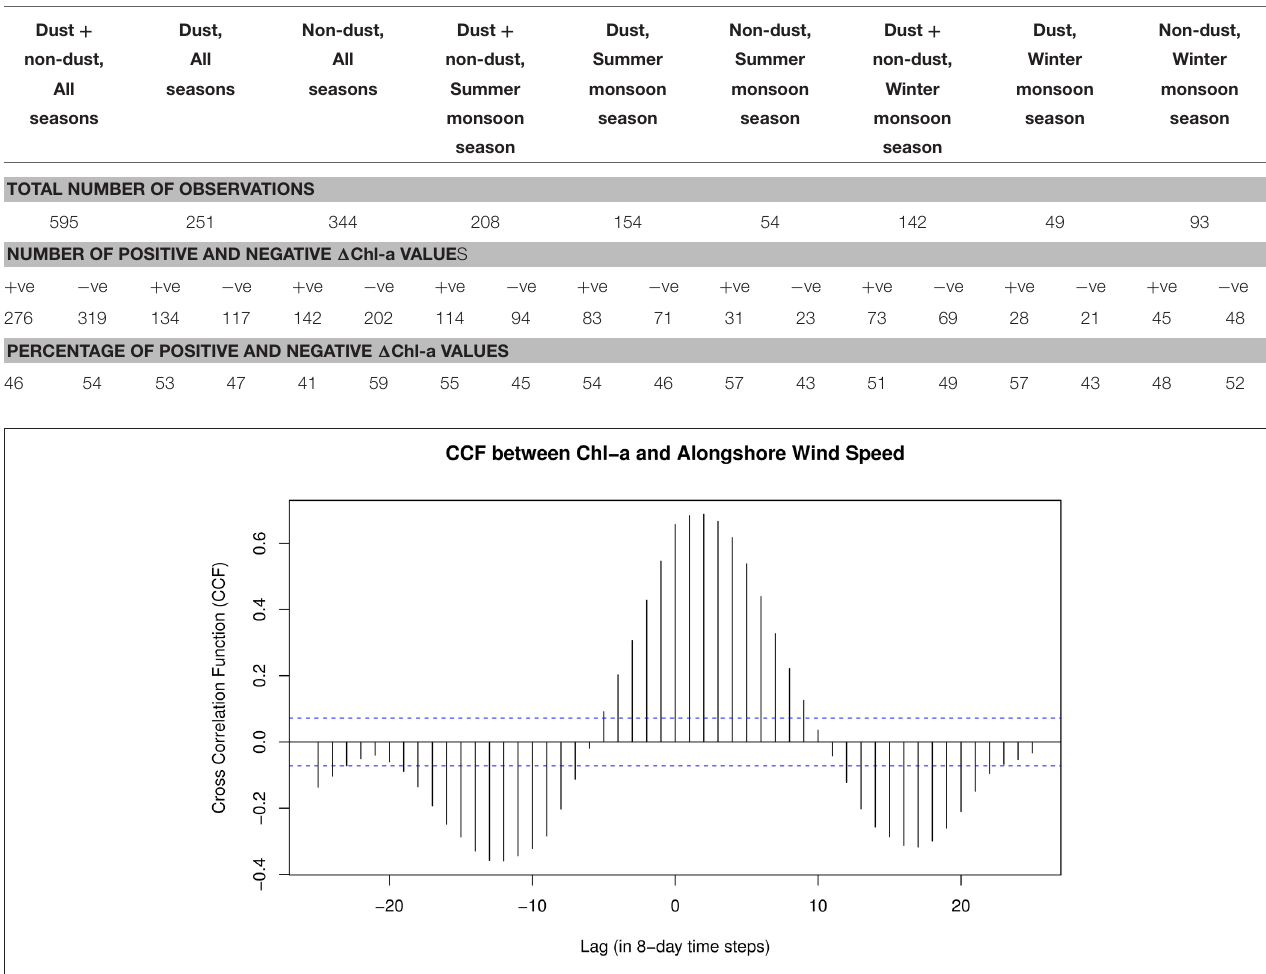
FIGURE 6 | Cross Correlation Function between Chl-a and alongshore wind speed for study area off Somalia. Time step is 8